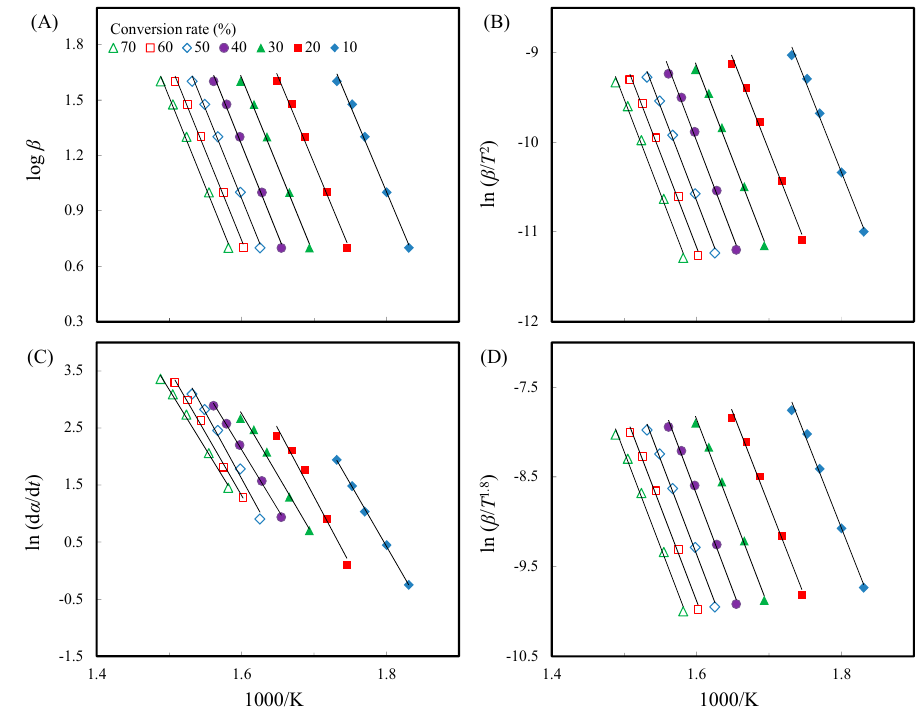
Figure 7. Typical iso-conversional plots of Flynn-Wall-Ozawa (F-W-O) ( A ); modified Coats-Redfern (C-R) ( B ); Friedman ( C ); and Starink ( D ) methods for unmodified slicewood.